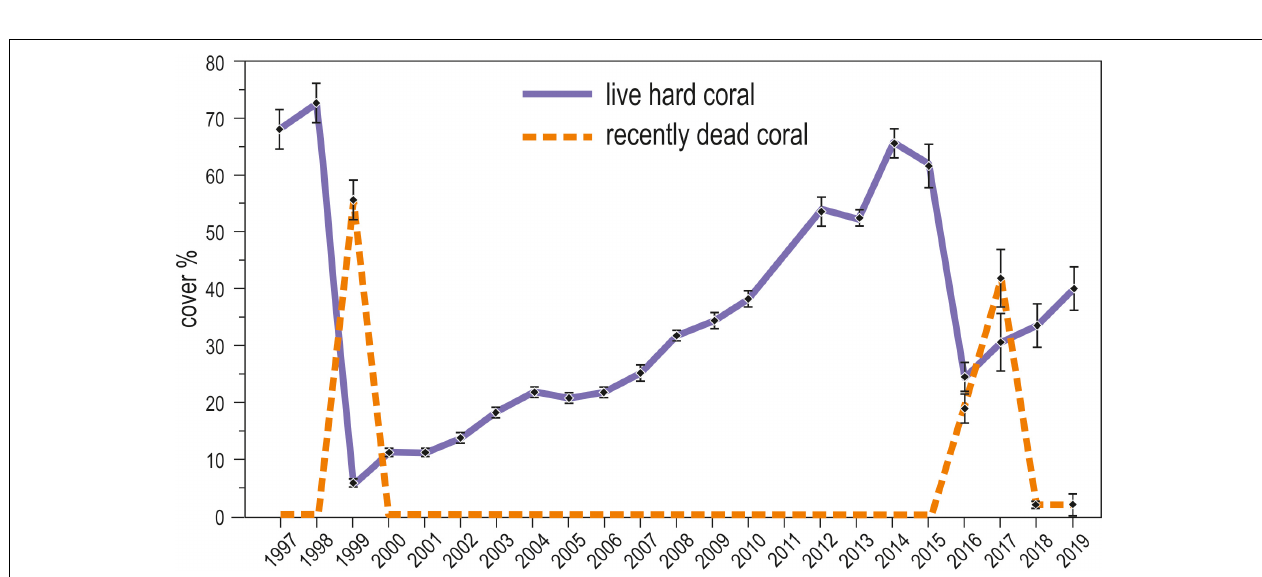
FIGURE 2 | (A) Twenty-three year trend (1997–2019) of the total number of inhabitants of the Maldives (number of inhabitants = 5.584 year-10889; R 2 = 0.997) (from United Nations, Department of Economic and Social Affairs, Population Division; National Bureau of Statistics in Maldives, Department of National Registration); (B) Number of inhabitants according to the national census of 1995, 2000, 2006, and 2014 (available at http://statisticsmaldives.gov.mv/yearbook/statisticalarchive) for the four main atolls compared in this study: North and South Malé (number of inhabitants = 3.659 year-7240; R 2 = 0.987), Ari (number of inhabitants = 0.106 year-199.2; R 2 = 0.733), and Felidhoo (number of inhabitants = –0.006 year-1396; R 2 = 0.492); (C) Twenty-three year trend (1997–2019) of tourists arrivals in the Maldives (tourists arrivals = 2E-56 · e 0 . 067 · year ; R 2 = 0.943) (from Ministry of Tourism data, compiled from annual reports and available at https://www.tourism.gov.mv/downloads/stats); (D) Twenty-three year trends (1997–2019) of the number of beds in the resorts of the four main atolls compared in this study: North and South Malé (number of beds = 9E-27 · e 0 . 034 · year ; R 2 = 0.779), Ari (number of beds = 3E-22 · e 0 . 029 · year ; R 2 = 0.920), and Felidhoo (number of beds = 3E-36 · e 0 . 043 · year ; R 2 = 0.821) (from Ministry of Tourism data, compiled from annual reports and available at https://www.tourism.gov.mv/downloads/stats).